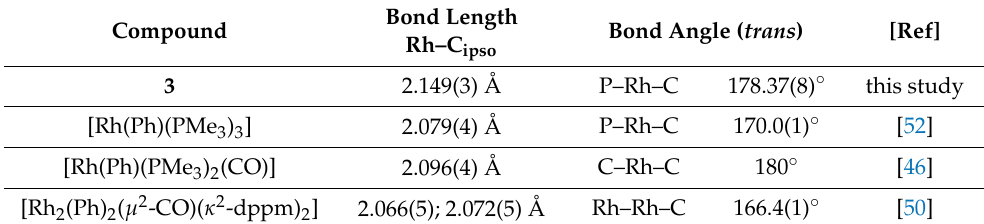
Table 1. Comparison of crystallographic data of Rh I phenyl